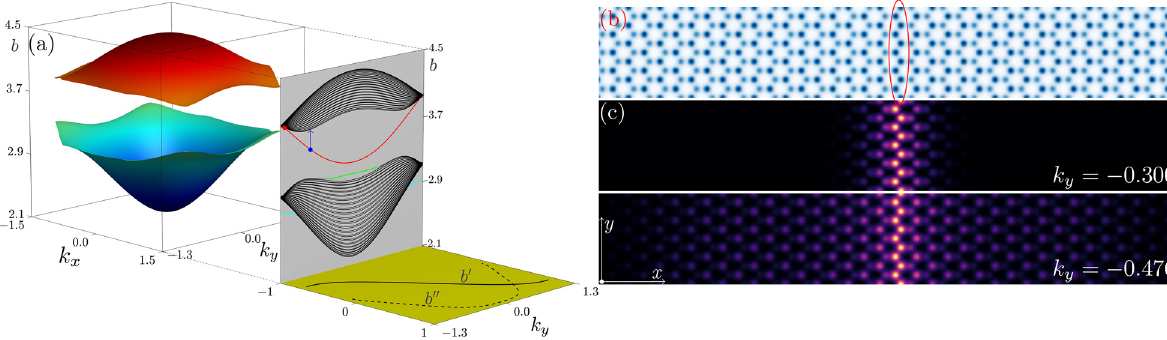
Figure 1: Band structures and linear valley Hall edge states. (a) Band structure b ( k x , k y ) of an inversion-symmetry broken honeycomb lattice. In the gray plane, the band structure of the composite honeycomb lattice with boundaries along x is displayed, in which the red curve is the topological valley Hall edge state, black curves are bulk states,whilegreenandcyancurvescorrespond to trivialedgestateson theouter boundaries of thecompositelattice.Inthe yellow plane,the fi rst-order b ′ (solid curve) and second-order b ″ (dashed curve) derivatives of the propagation constant of the edge state are shown. (b) Honeycomb lattice with a domain wall (indicated by the red ellipse) created by the opposite detuning at x < 0 and x ≥ 0. (c) Pro fi les of the edge states corresponding to the blue ( k y = − 0.3K) and red ( k y = − 0.476K) dots in